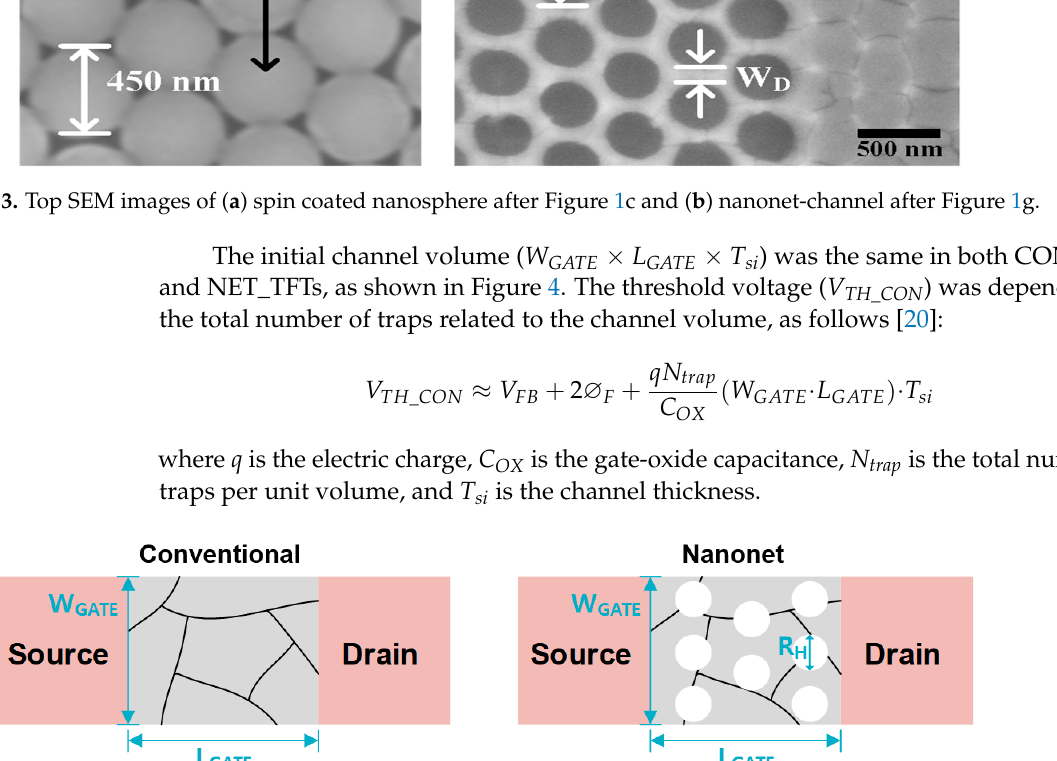
Figure 4. Top-view scheme of conventional planar TFTs (CON_TFTs) ( left ) and nanonet-channel low-temperature polysilicon TFTs (NET_TFTs) ( right ).